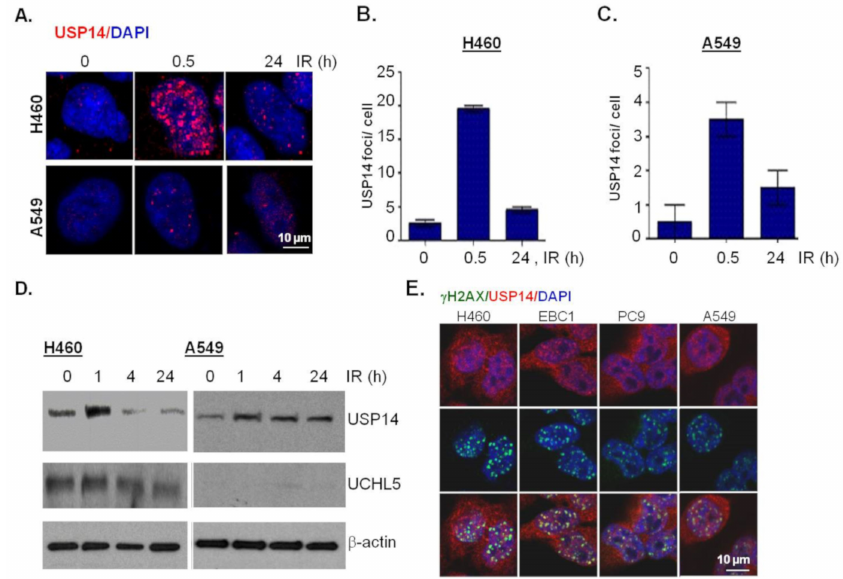
Figure 2. Ionizing radiation (IR) increases protein expression and double-strand break (DSB) recruitment of USP14. ( A ) Representative confocal images and ( B,C ) quantification of USP14 IR-induced foci (IRIF) at the indicated time points in H460 and A549 cells following 10 Gy IR treatment. Nuclei were stained with DAPI. ( D ) Western blot analysis for USP14 and UCHL5 in H460 and A549 cells at the indicated times after IR treatment. β -actin was used as the loading control. ( E ) Representative confocal images following co-immunostaining to show co-localization of USP14 and γ H2AX IR-induced foci (IRIF) in the indicated cell lines at 1 h following 5 Gy IR treatment. Nuclei were stained with DAPI. Data shown are the means ± SEM ( n =